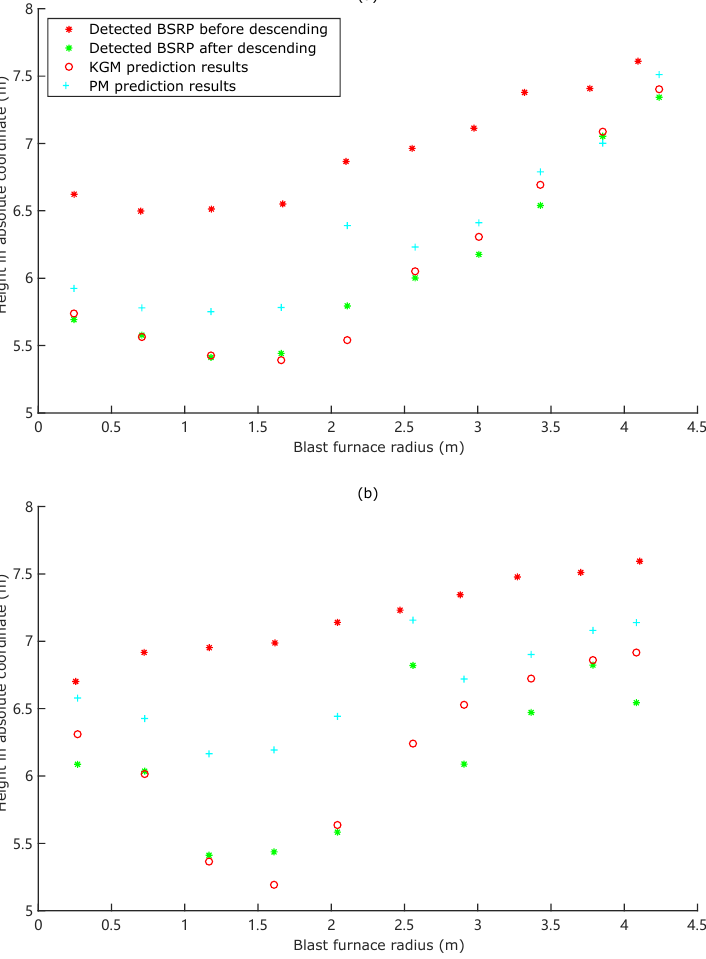
Figure 9. Comparison of prediction accuracy of BSRP. ( a ) Results for Case 1; and ( b ) results for Case